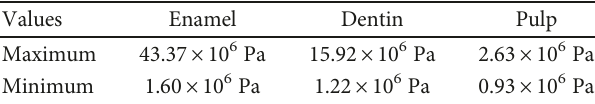
Table 6: 3rd degree caries : von Mises stresses results.